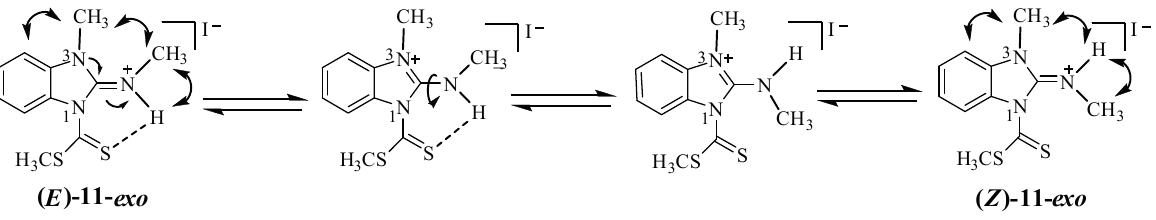
Scheme 7. Isomerization of 11 - exo in DMSO- d 6 solution. nOes are represented by double headed curved arrows.